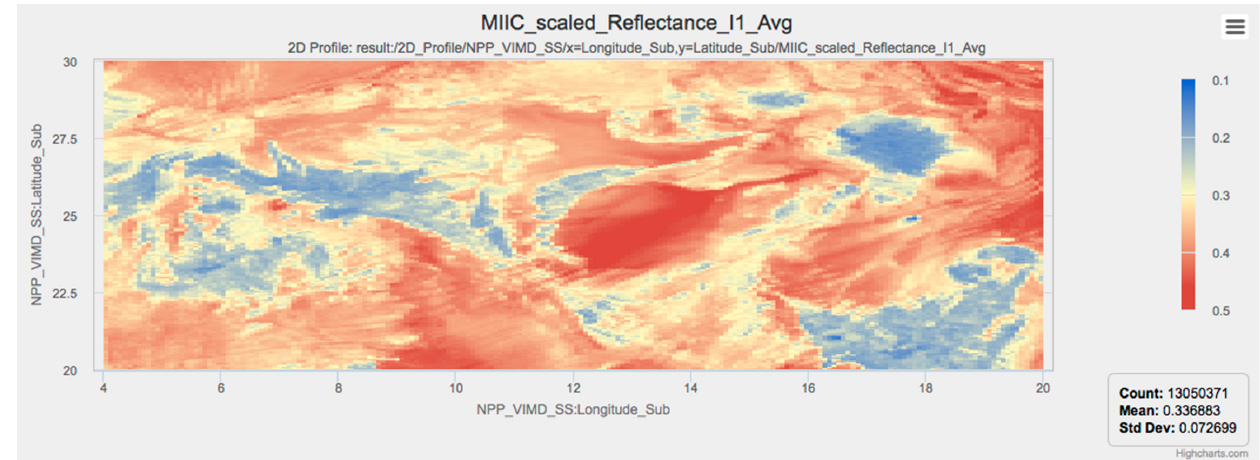
Figure 8. Surface site acquisition, North Africa (20 ◦ –30 ◦ N, 4 ◦ –20 ◦ E); VIIRS band I1 reflectance, August 2014; server-side cloud filter M15 BT > 300 K; scene reflectance dispersion σ / x = 21.7%.